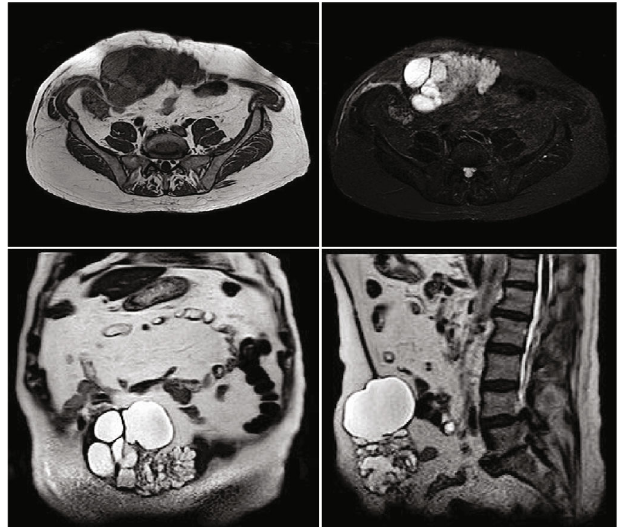
Figure 3: Nodular lesion of cystic predominance, multilocated, hyperintense in T1 and hypointense in T2, which a ff ects the rectus abdominis muscle, exceeding the midline.